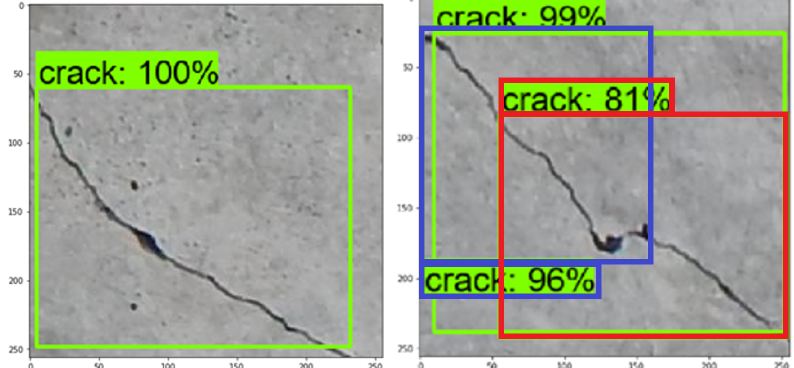
Figure 8. Example of two tested images: the crack on the left image properly detected and localized as one crack (with certainty 100%), the crack on the right image simultaneously properly detected as one crack (with certainty 99%) and not properly detected as two cracks (with certainty 96% and 81%,